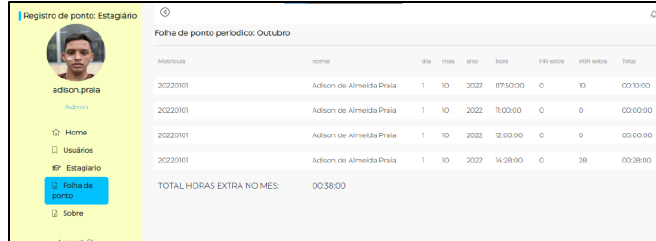
Figure 24: Trainee's time clocking register